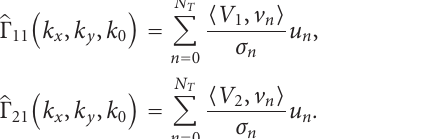
where we considered that f (1,1) entry of Γ , a and b are the guide transverse dimensions (with a > b ), and k t = ( k x , k y